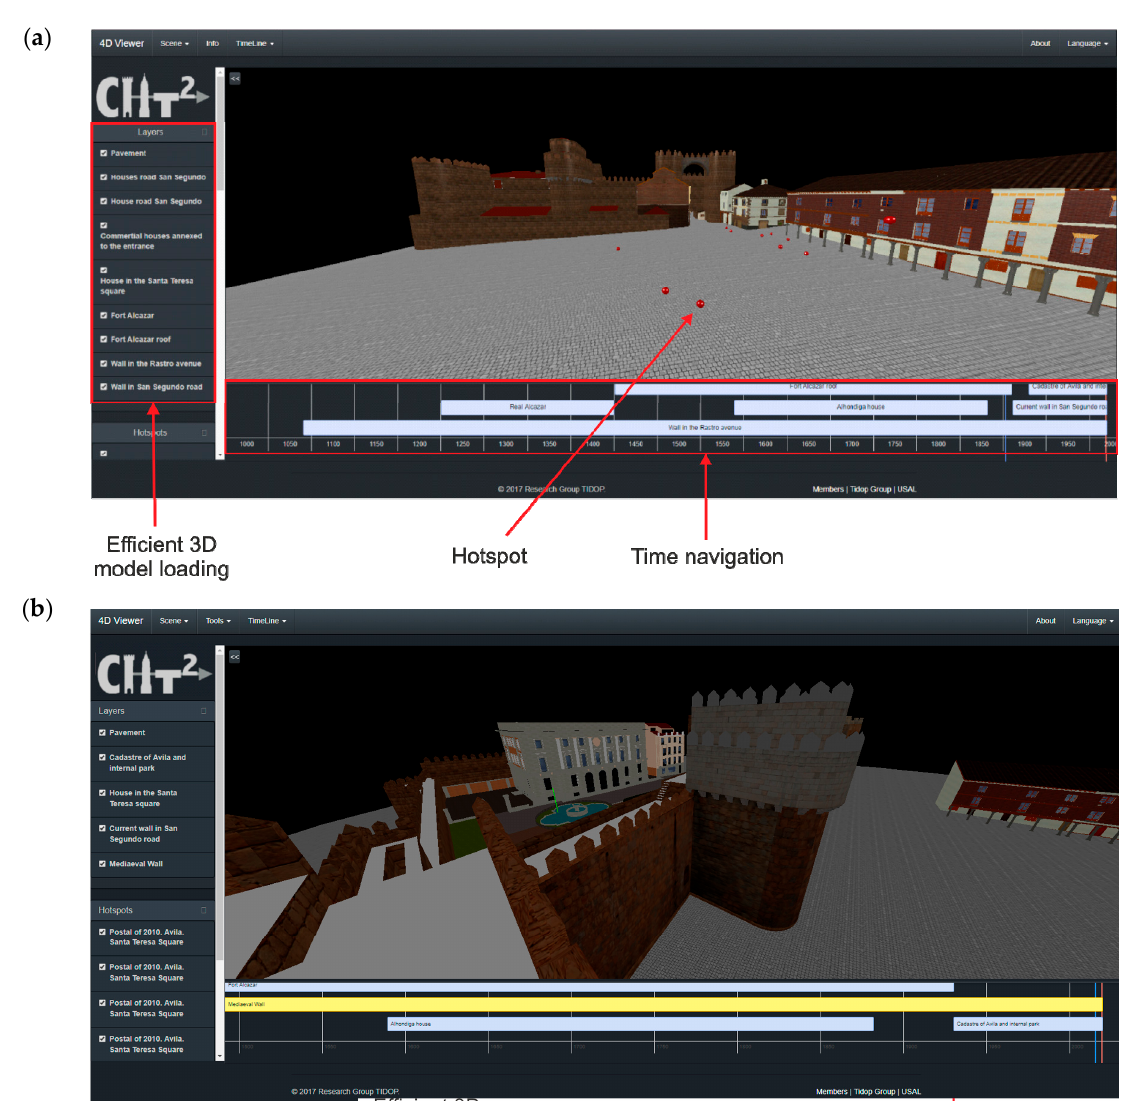
Figure 13. Front-end interface of the viewer developed: ( a ) appearance of the Alcázar gate of Ávila around 1900; ( b ) current appearance of the Alcázar gate of Ávila (2018).